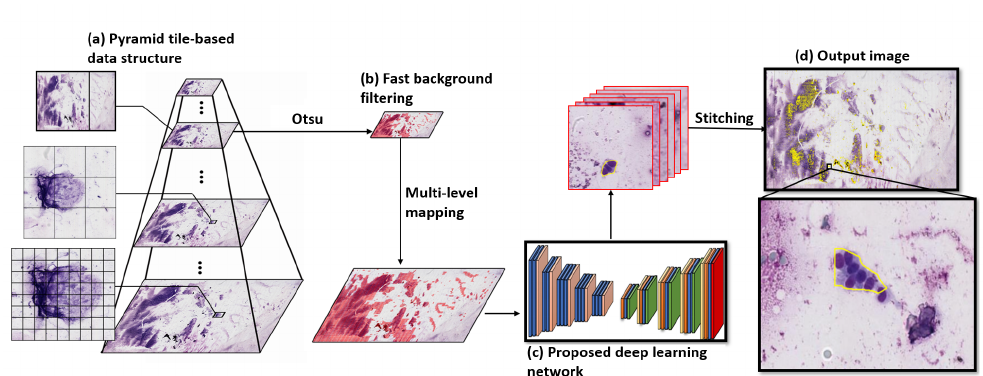
Figure 2. The overview of the proposed deep learning analysis system. ( a ) Each WSI is converted into a patch-based hierarchical structure (each tile is represented by a black rectangular box). ( b ) Each WSI is processed using the fast background filtering model to efficiently discard all the background. ( c ) Each tile is examined by the proposed deep convolutional neural network for segmentation of metastatic lesion from EBUS-TBNA WSIs. ( d ) The tiles are then stitched together to obtain an output